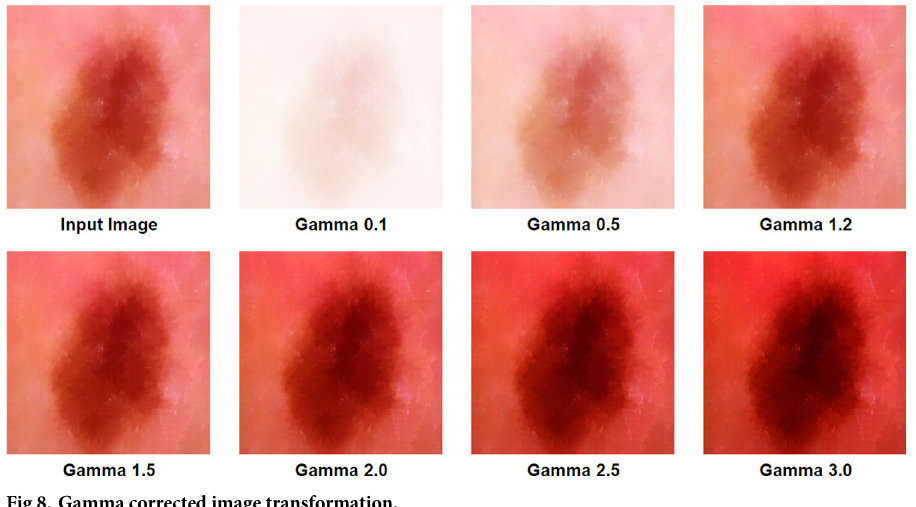
Fig 8. Gamma corrected image